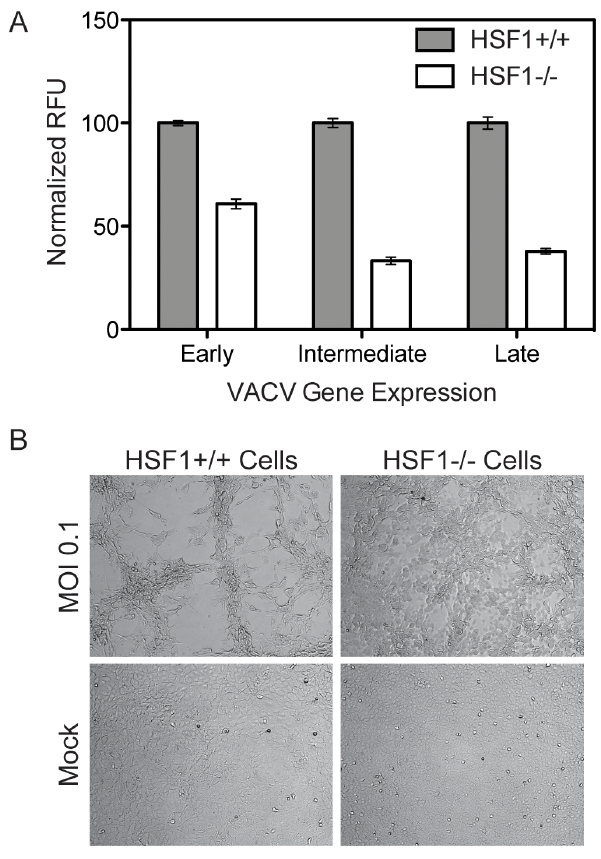
Figure 5. HSF1 null MEF cells support significantly less VACV infection. (A) HSF1 null MEF cells infected with VACV-TrpV show significantly less early (Venus), intermediate (mCherry) and late (TagBFP) gene expression compared to wild type MEFs. Three independent experiments were completed in triplicate; this is a representative plot showing normalized relative fluorescent units (RFU) with standard error. (B) Brightfield images show HSF1 null MEFs exhibit less cytopathic effects than wild type MEFs when infected with VACV at an MOI of 0.1 at 18 hpi. Mock infected HSF1 null and wild type MEFs are included for